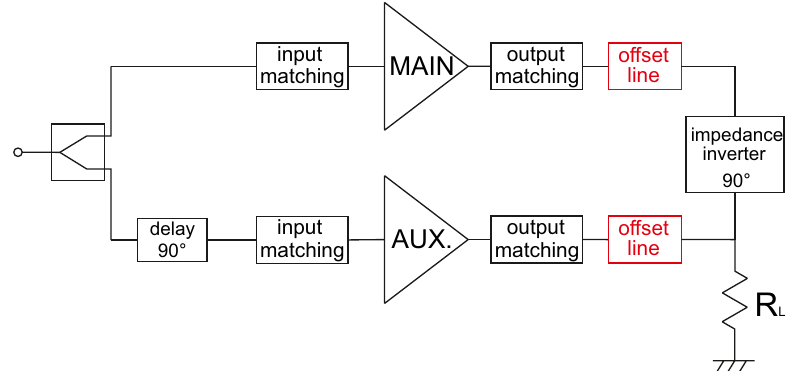
Figure 8. DPA schematic including matching networks and (red) offset